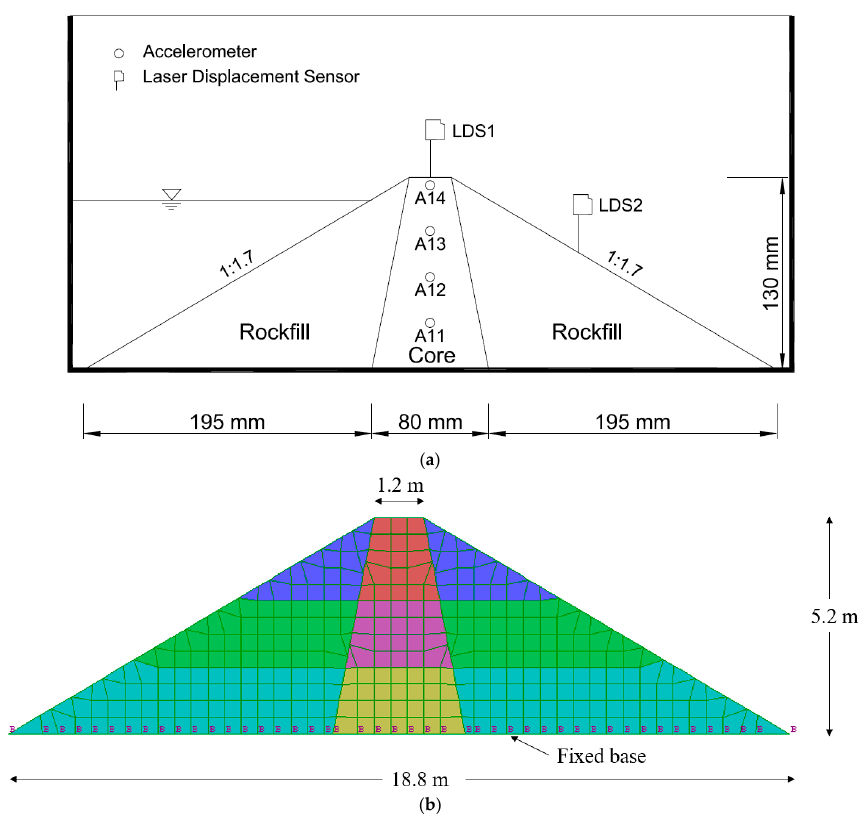
Figure 3. The models of ECRD used for validation. ( a ) Centrifuge model [18] and ( b ) numerical model of ECRD from this investigation.